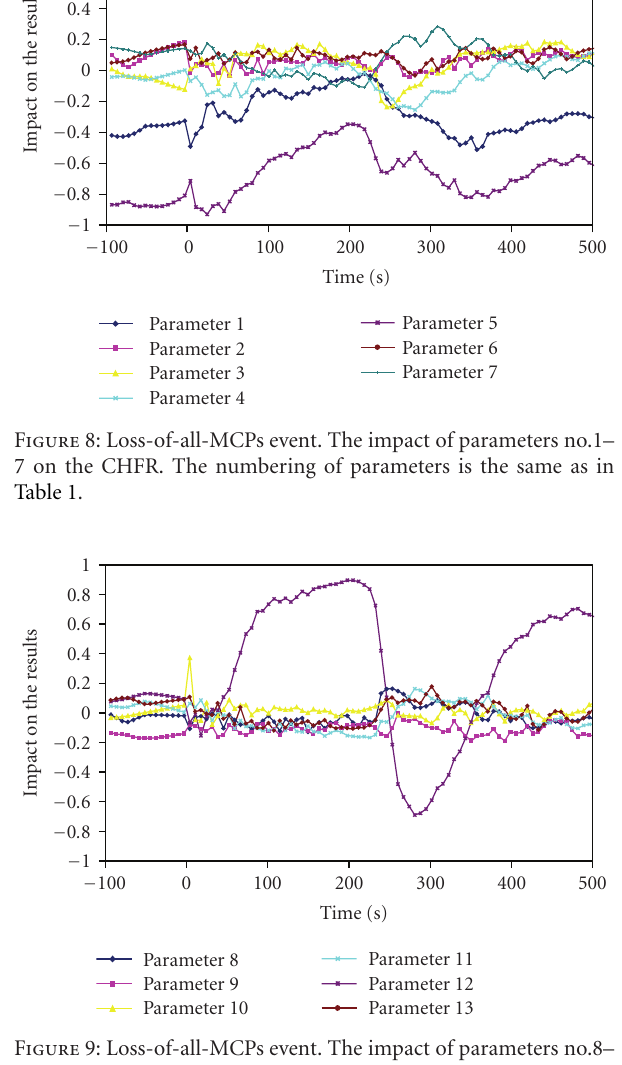
Figure 9: Loss-of-all-MCPs event. The impact of parameters no.8– 13 on the CHFR. The numbering of parameters is the same as in Table 1.